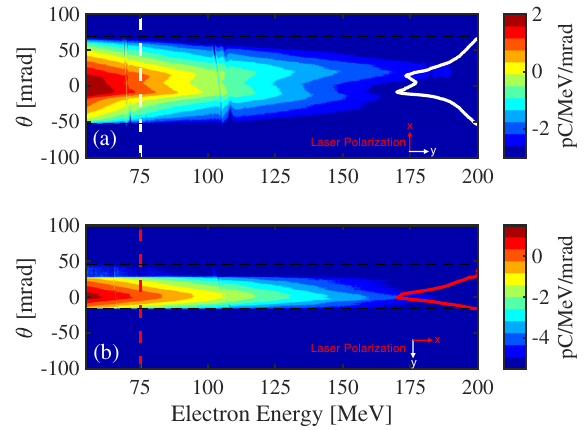
FIG. 4. Measured electron energy spectra for a plasma with electron density n e ¼ 3 × 10 17 cm − 3 dispersed (a) perpendicular and (b) parallel to the linear laser polarization direction. The contrast is adjusted and a line-out along the dashed line is plotted (solid line) to emphasize the forking feature in the dispersed electron profile. The dashed black line indicates the acceptance aperture of the magnet. Note that (a) and (b) were taken on two different shots with similar laser